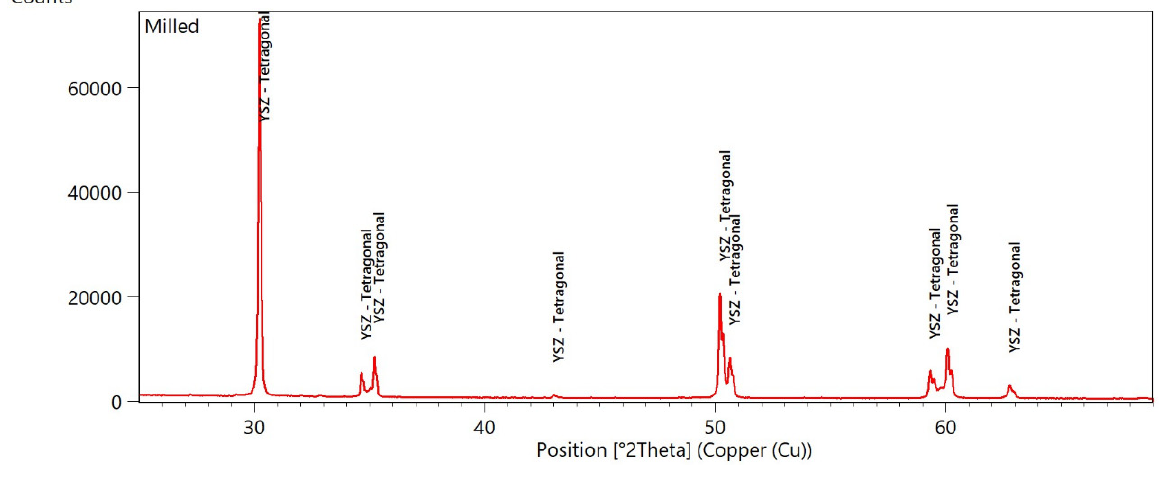
Figure 1. Milled and sintered sample.